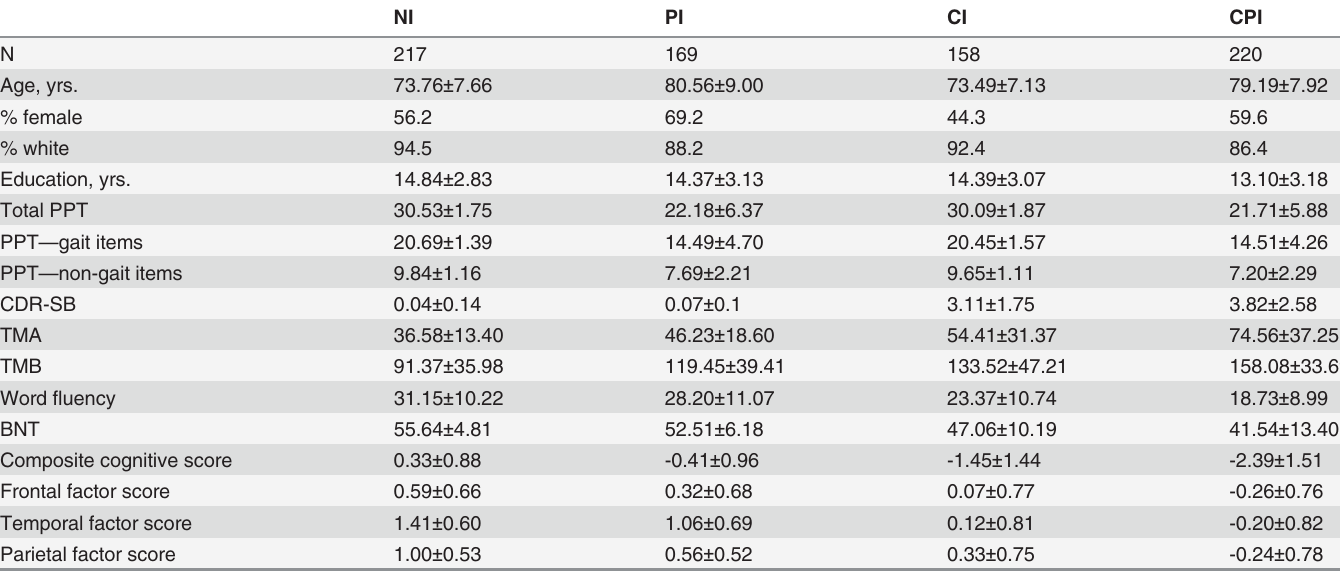
Table 1. Baseline characteristics according to impairment status.